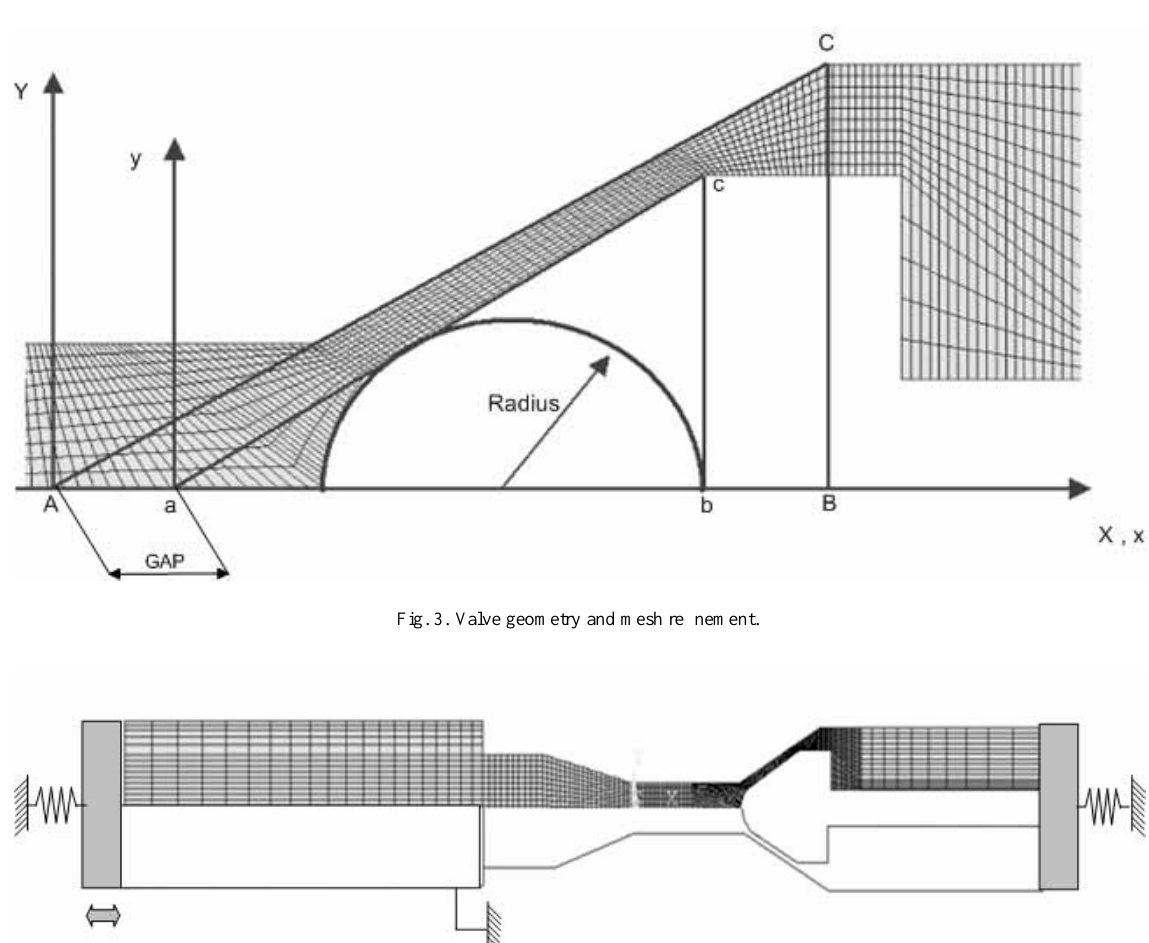
Fig. 4. Complete fluid-structure finite element